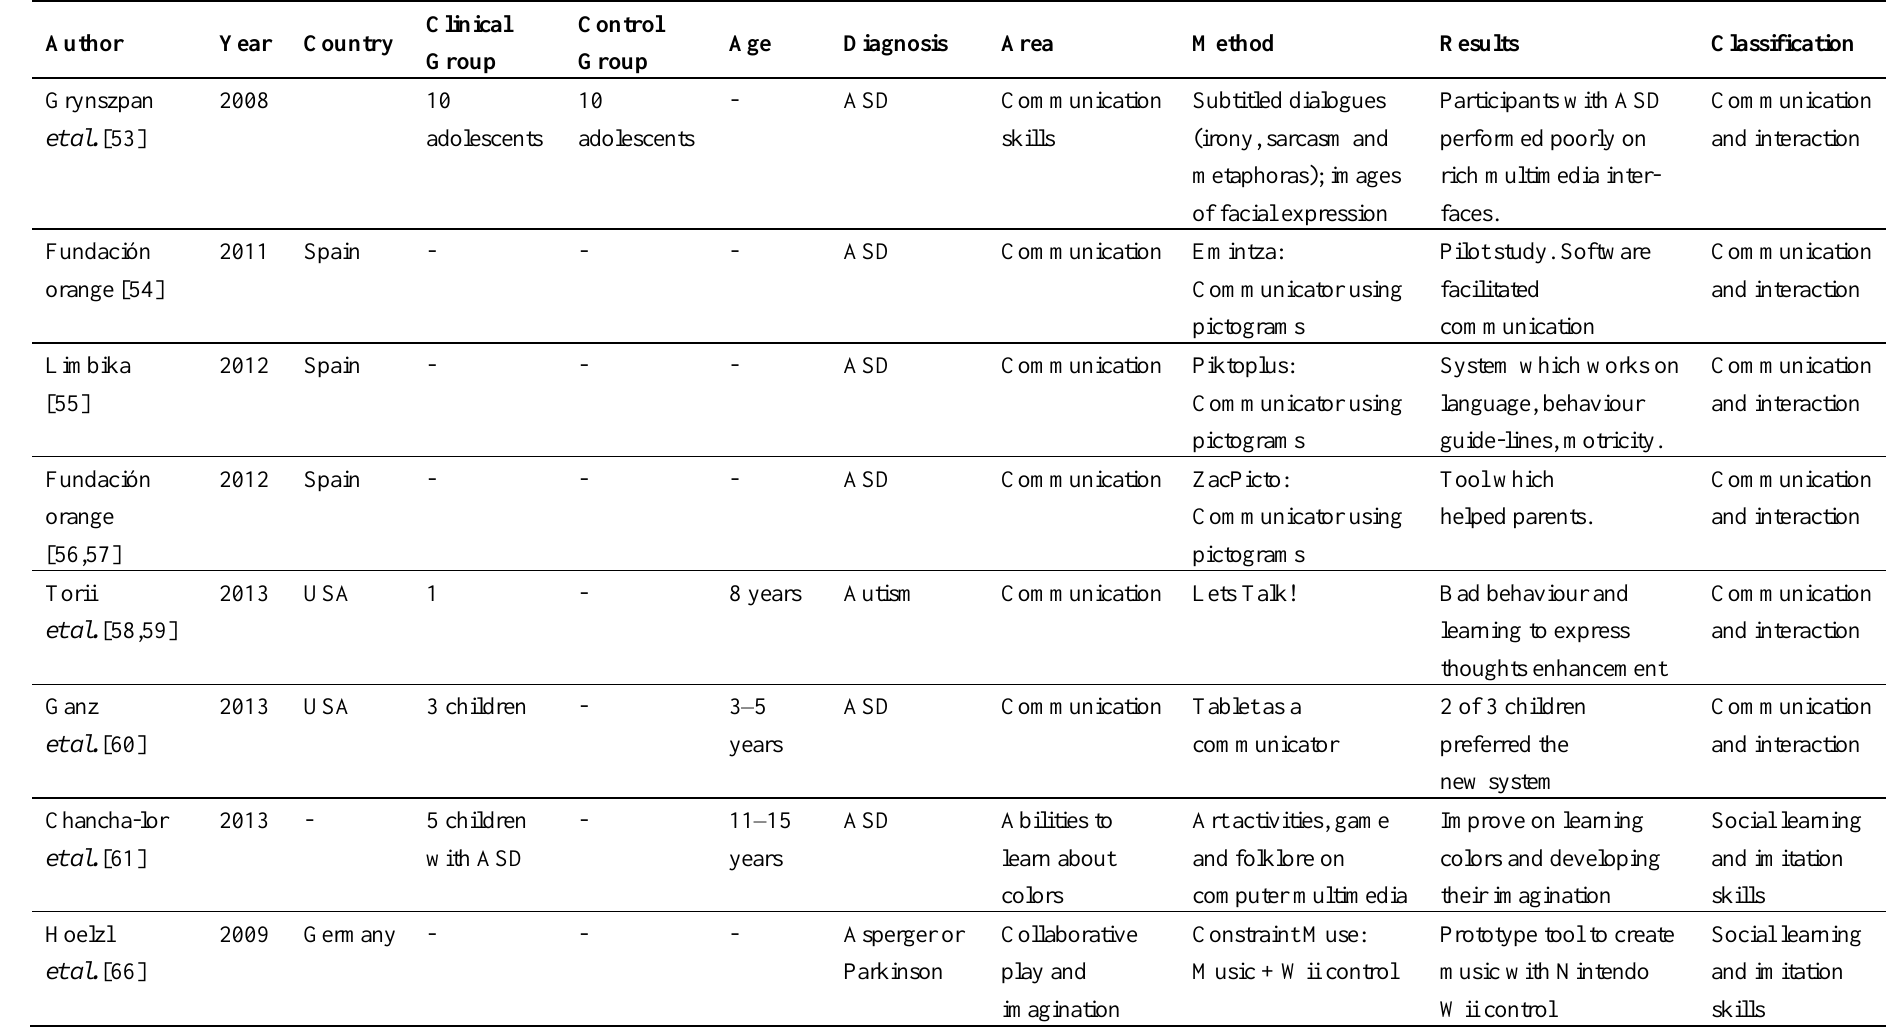
Table 2. Studies on dedicated